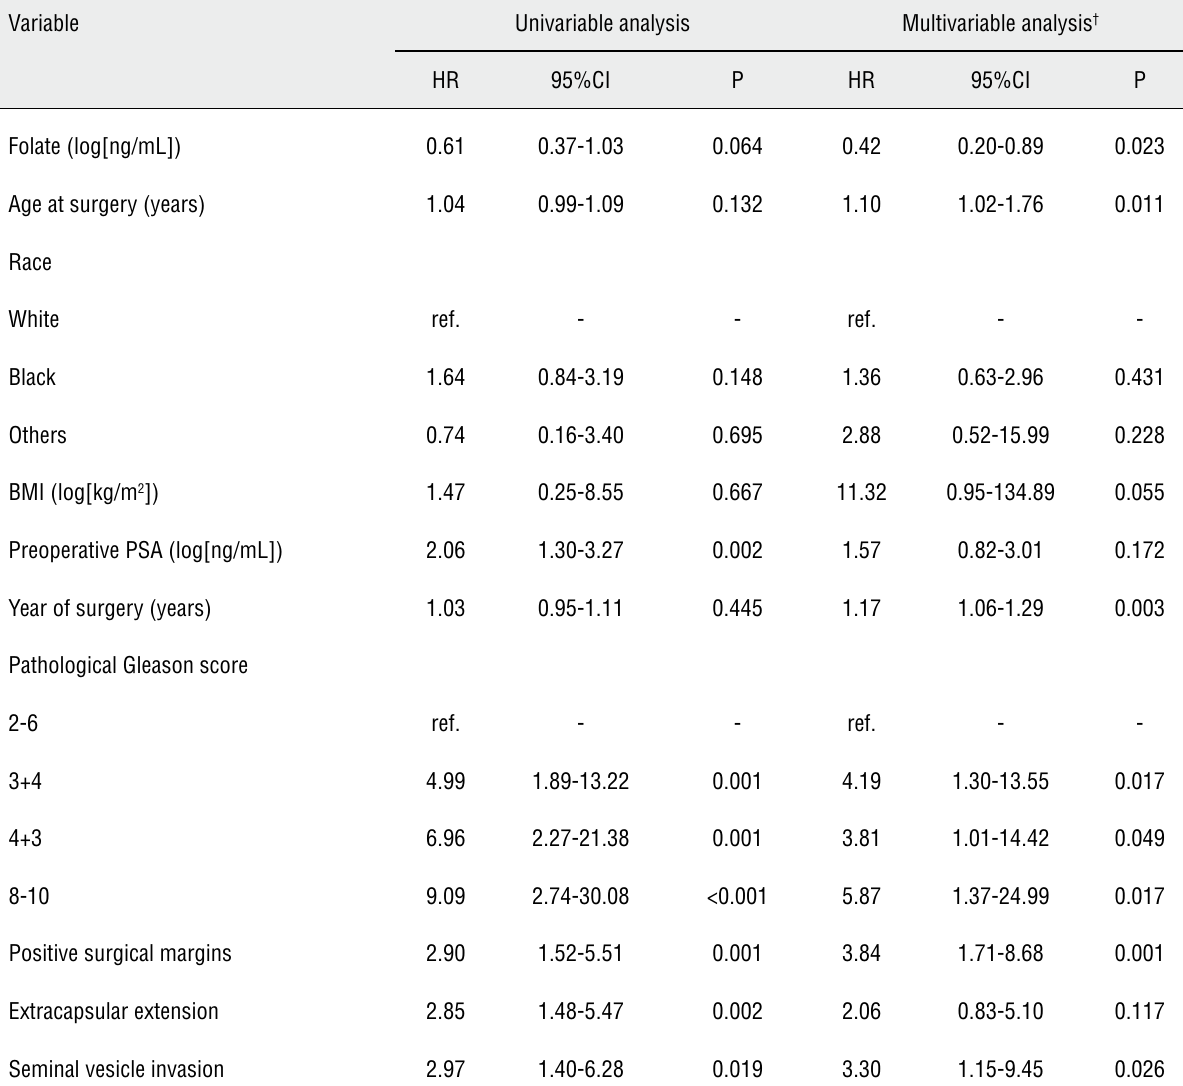
Table 3 - Univariable and multivariable predictors of biochemical